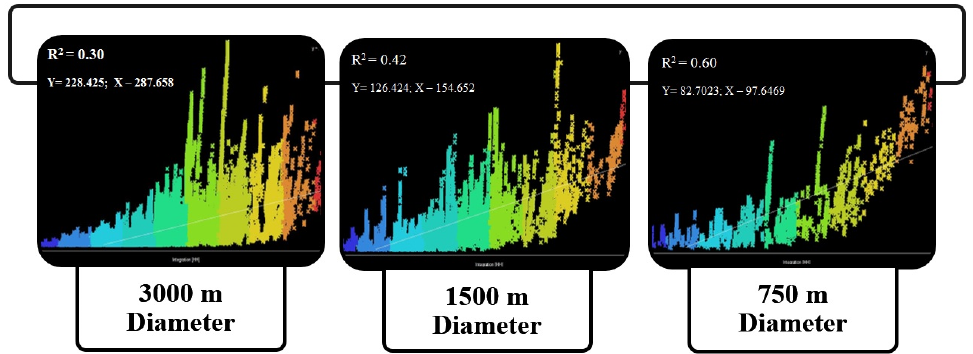
Figure 5. The spatial intelligibility values in different cases using the Space Syntax method, performed by the Depthmap software.